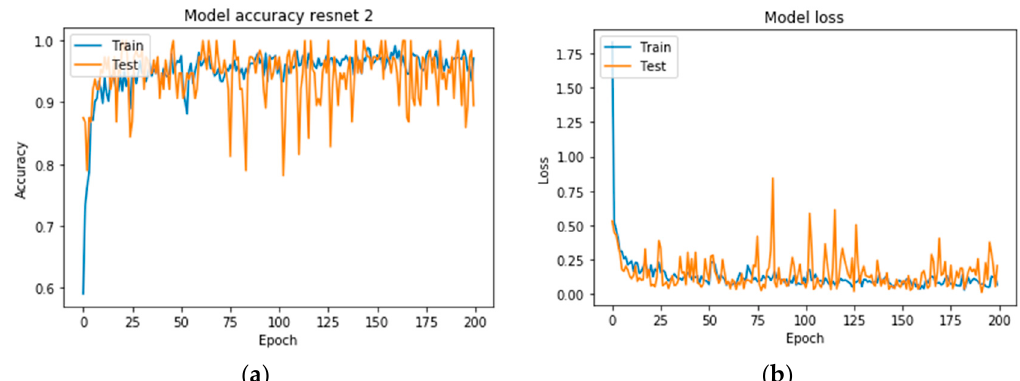
Figure A2. Precision curves for Resnet50 ( a ) accuracy and ( b ) loss.